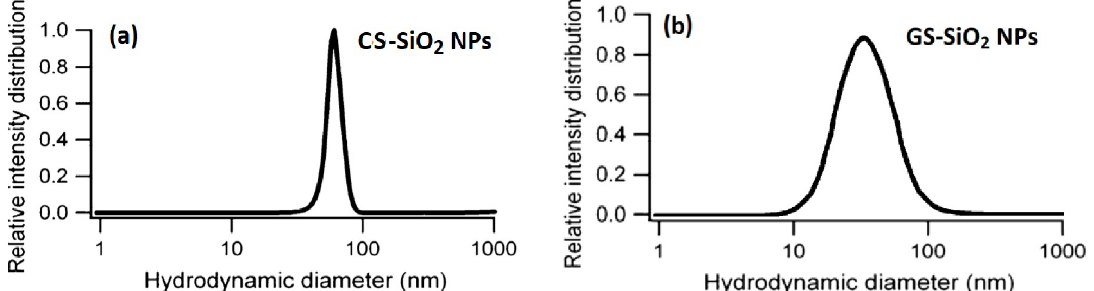
Fig 8. DLS for (a) CS-SiO 2 NPs and (b) GS-SiO 2